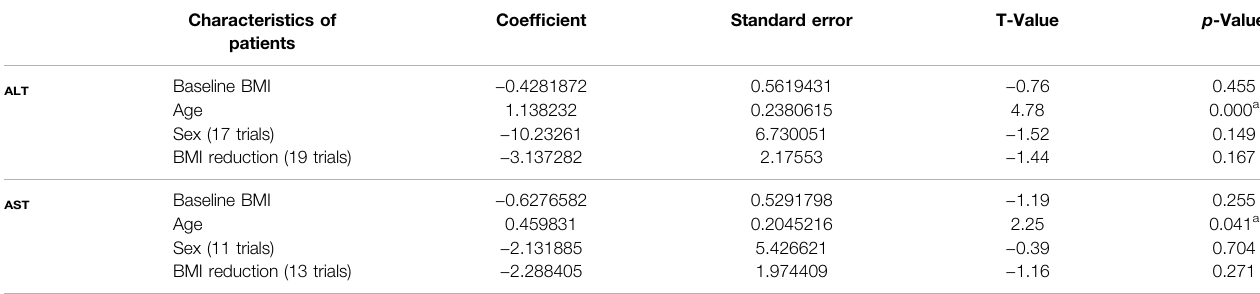
TABLE 2 | Meta-regression analysis to identify the effective variables.